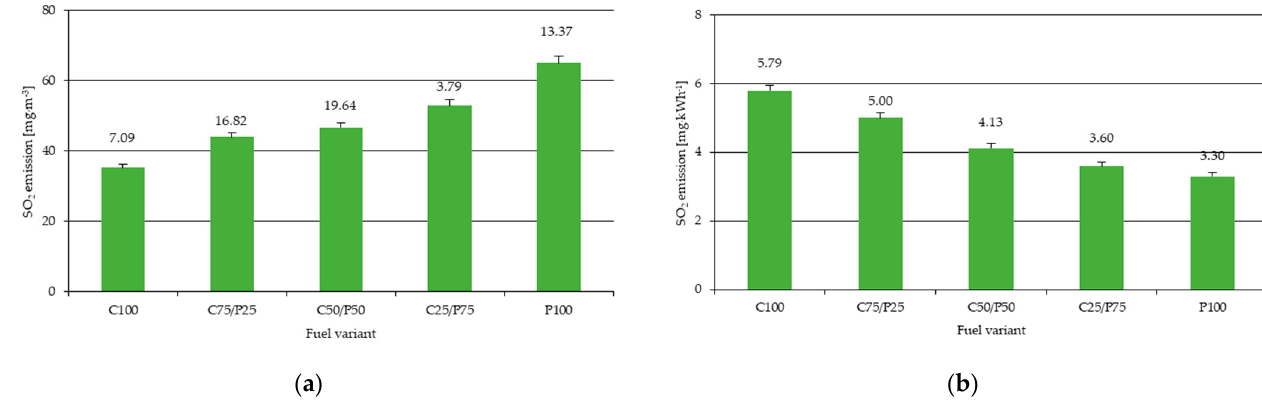
Figure 8. SO 2 emission per ( a ) 1 m 3 exhaust gas; ( b ) 1 kWh thermal energy.